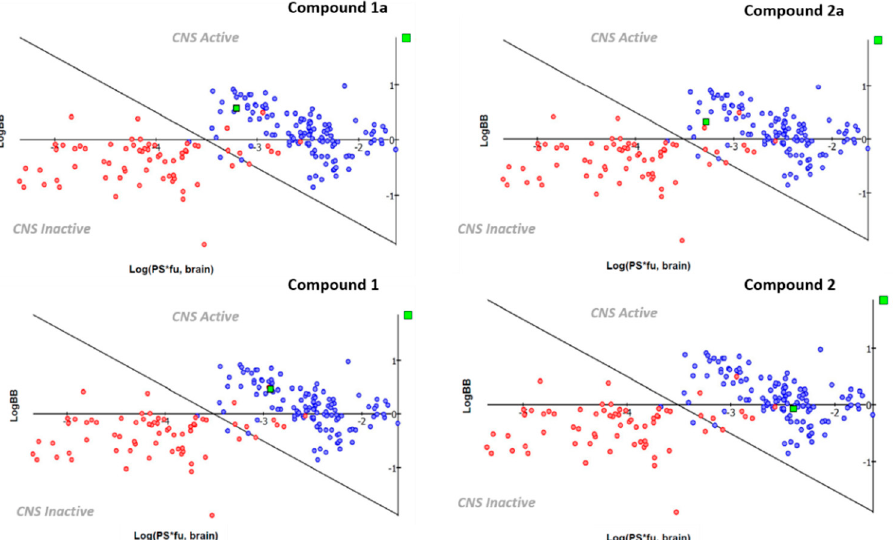
Figure 5. Scheme of the predicted BBB permeability featured by the previous 1a and 2a and by the novel 1 and 2 mTAAR5 antagonists. CNS inactive and active drugs, as reported in the ACD/Percepta training libraries, are reported in red and blue, respectively.